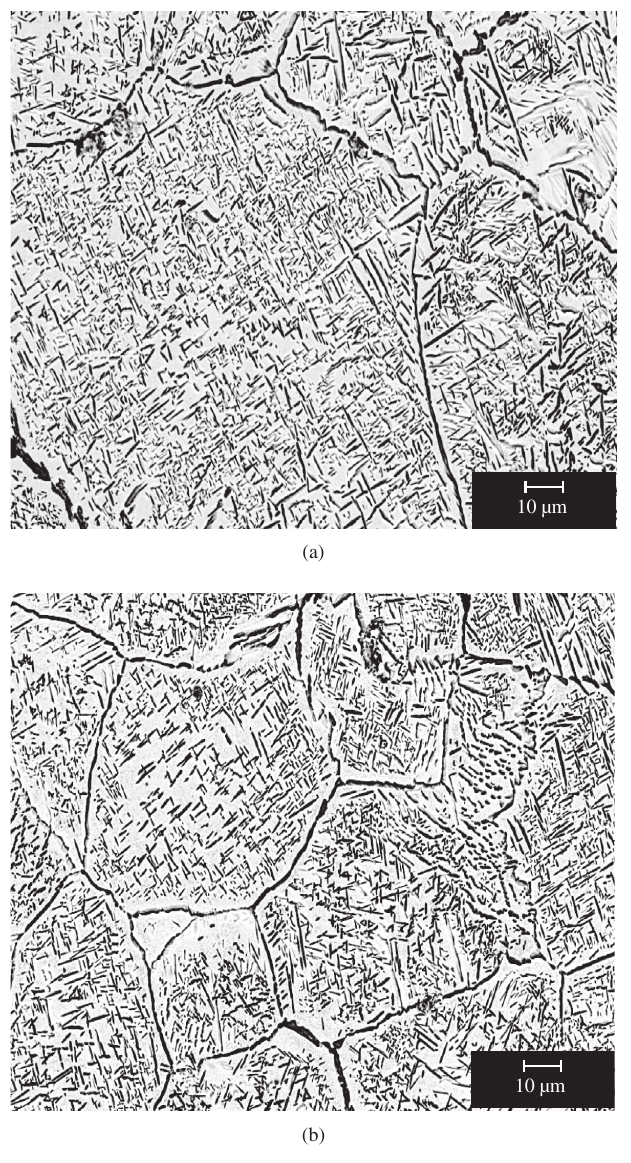
Figure 3. SEM images of the aged TNZT sample. a) Aged at 600 °C for 4 hours; and b) Aged at 600 °C for 6 hours.